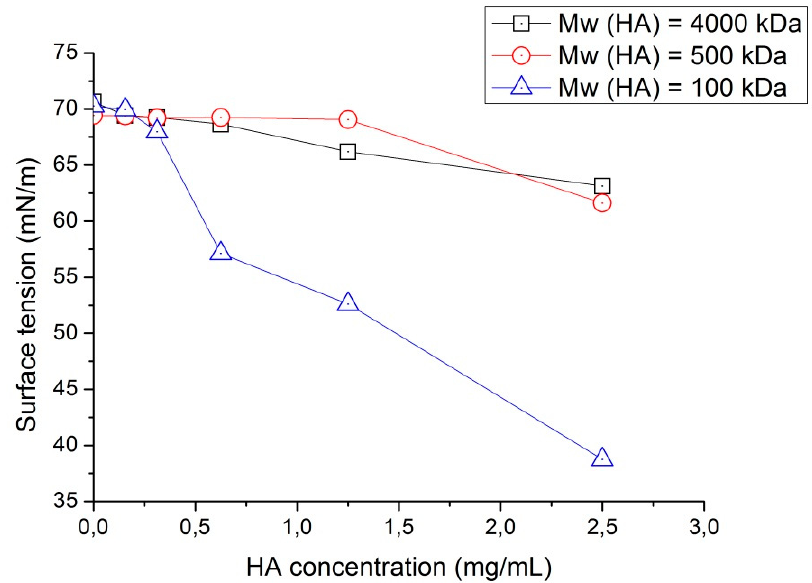
Figure 8. Surface tension of hyaluronic acid as a function of concentration in deionized water (plotted based on the experimental data from [59]).